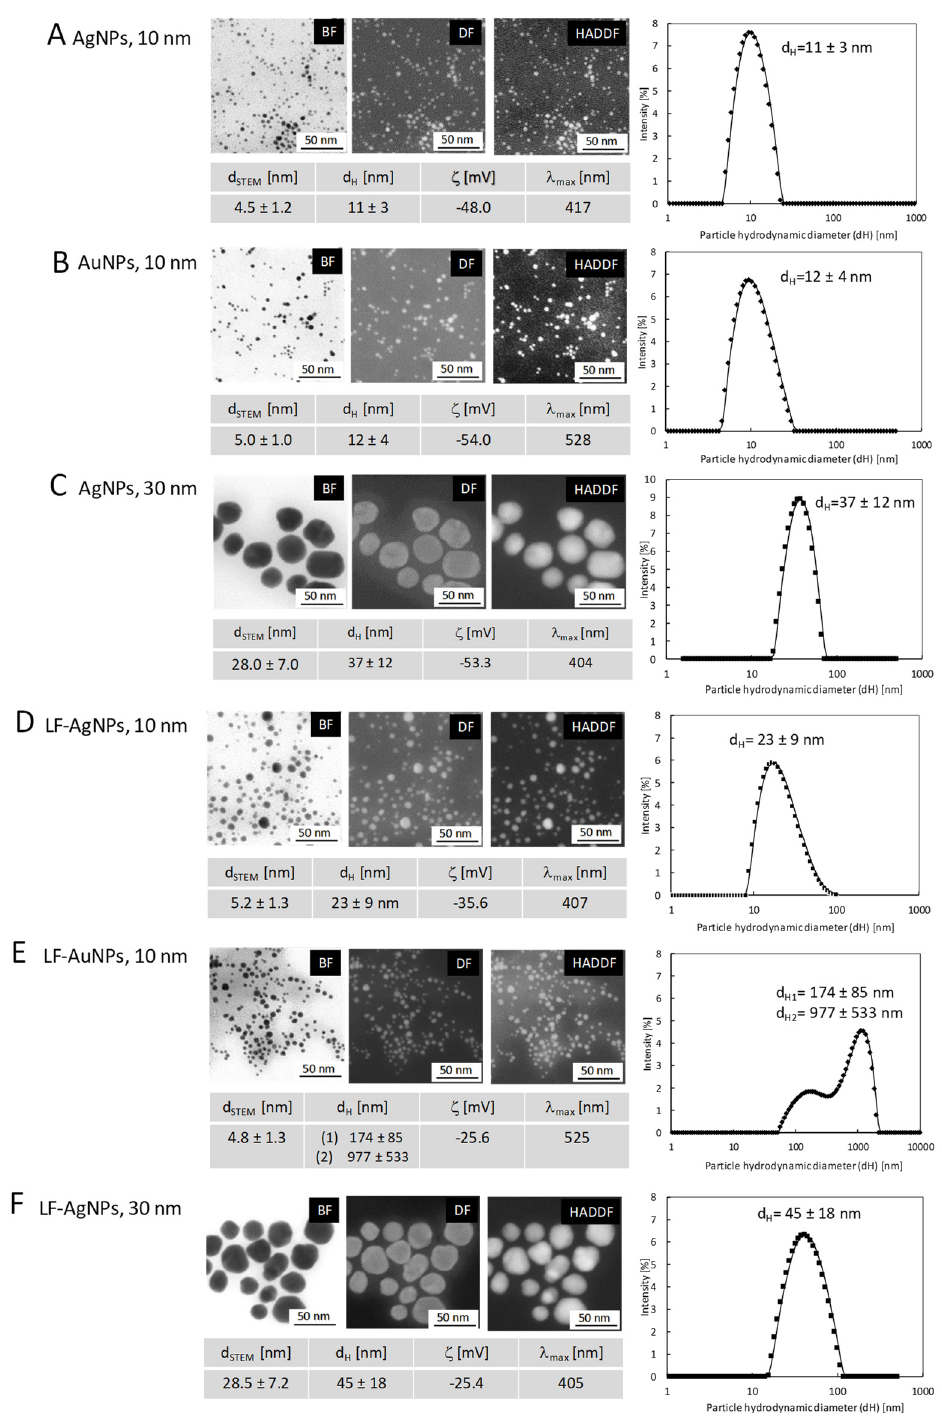
Figure 1. HR-SEM image, DLS size distribution histogram, and overall results of nanoparticles and nanoconjugates characterization results of NPs ( A – C ) and LF-NPs conjugates ( D – F ) (d STEM —the mean size of metallic core; d H —hydrodynamic particles size; ζ —Zeta potential; λ max absorption band maximum).